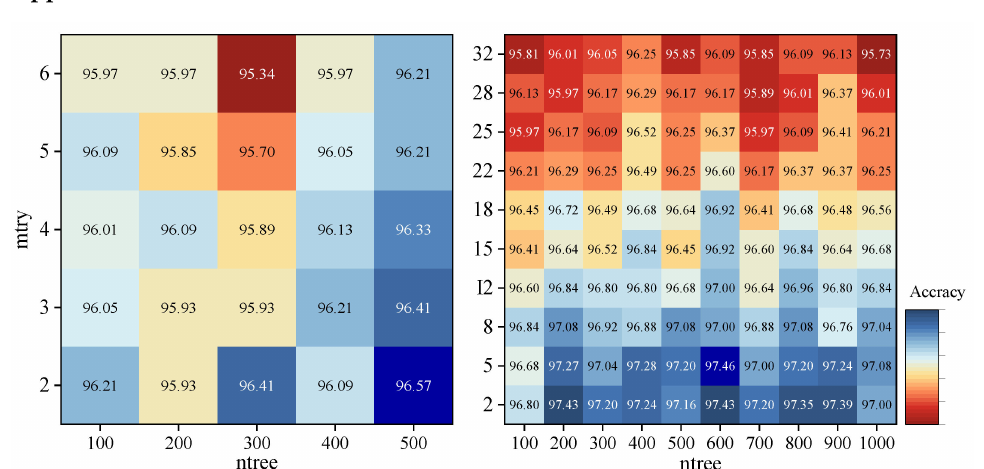
Figure A1. Hyperparameter grid search of RF in pixel-based ( right ) and object-based ( left ) classifica- tion methods under optimal feature combination.